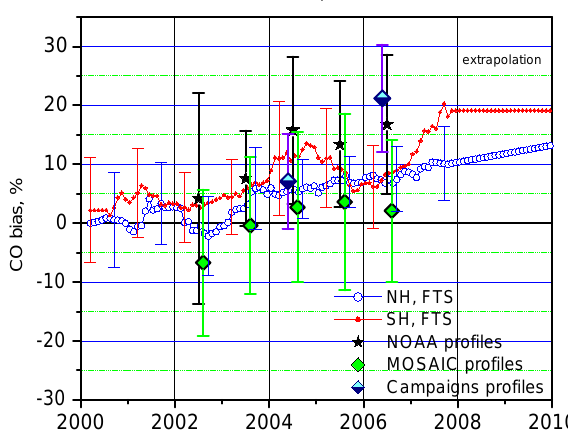
Fig. 6. CO TC bias used as MOPITT V3 correction factor in com- parison with other validation results. The MOPITT bias vs. FTS is a sliding average of monthly means until December 2007 and an extrapolation thereafter. Emmons et al. (2009) validation results are plotted for